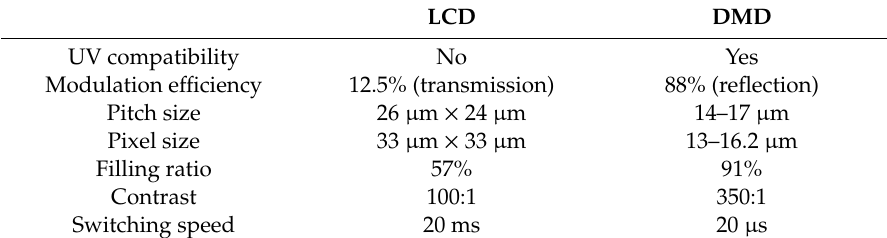
Table 1. Comparison between liquid crystal display (LCD) and digital micromirror device (DMD).